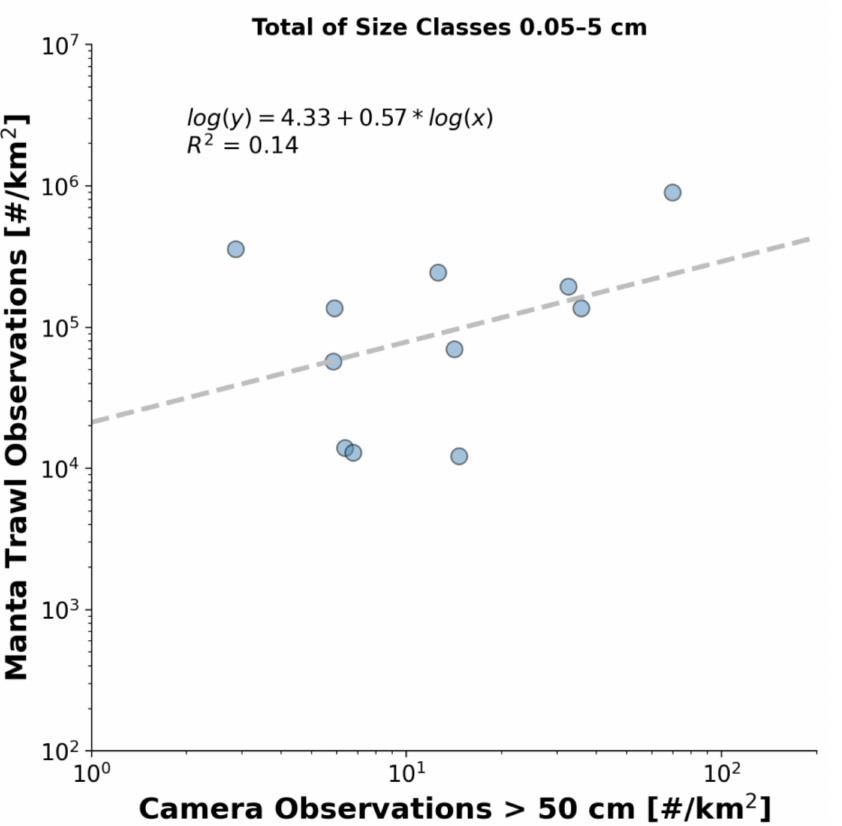
Figure A1. Log-Log scatterplot of the total Manta trawl observation size classes 0.05 (lower limit) to 5 cm (upper limit). The text in the upper left corner expresses the linear regression model of the log-transformed values and the model’s coefficient of determination (R 2 ) value. The gray dashed line indicates the fitted regression